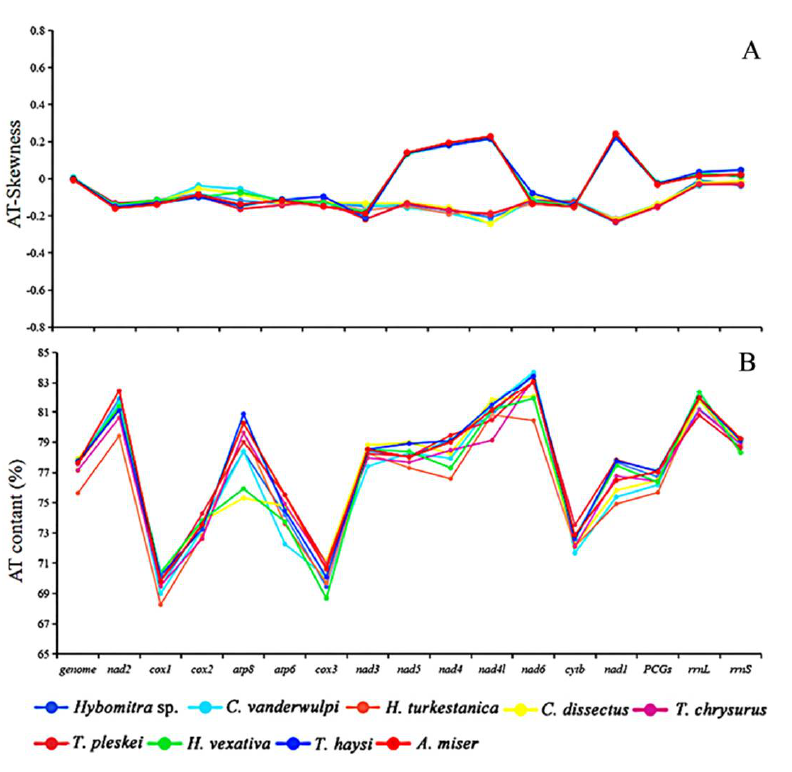
Figure 4. Information on AT content and skews of the investigated mitogenomes. ( A ) AT–skews (%). ( B ) AT content.